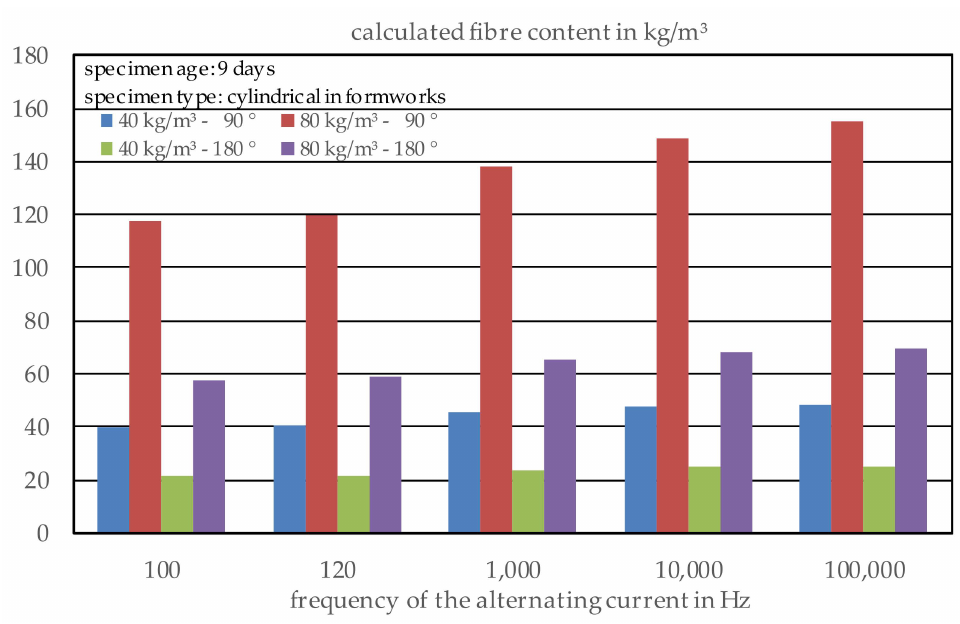
Figure 11. Calculated fibre content of the concrete specimens with different electrode arrays depend- ing on fibre content and frequency of the alternating current at a specimen age of 9